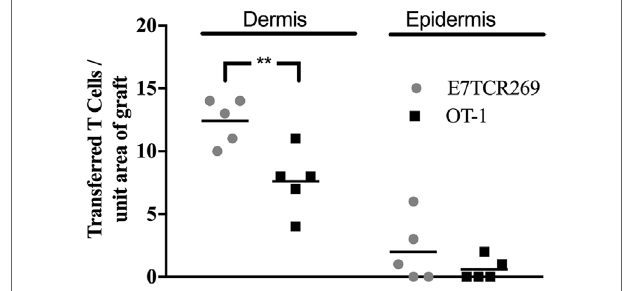
FigUre 4 | Migration of naïve Tcr transgenic cD8 T cells to grafted K14e7 ear skin . C57BL/6 mice received ear skin grafts from B6.K14.E7 mice. After 7 days, graft recipients received 2.5 × 10 6 naïve E7TCR269 and OT-1 CD8 T cells by i.v. injection, labeled as in Figure 2 . At 3 days after transfer, graft skin was harvested, frozen sections prepared, and the number of E7TCR269 and OT-1 CD8 T cells enumerated in epidermis and dermis. Data averaged over 35 areas of five independent grafting experiments are shown (** p < 0.05, ns = not significant; unpaired t